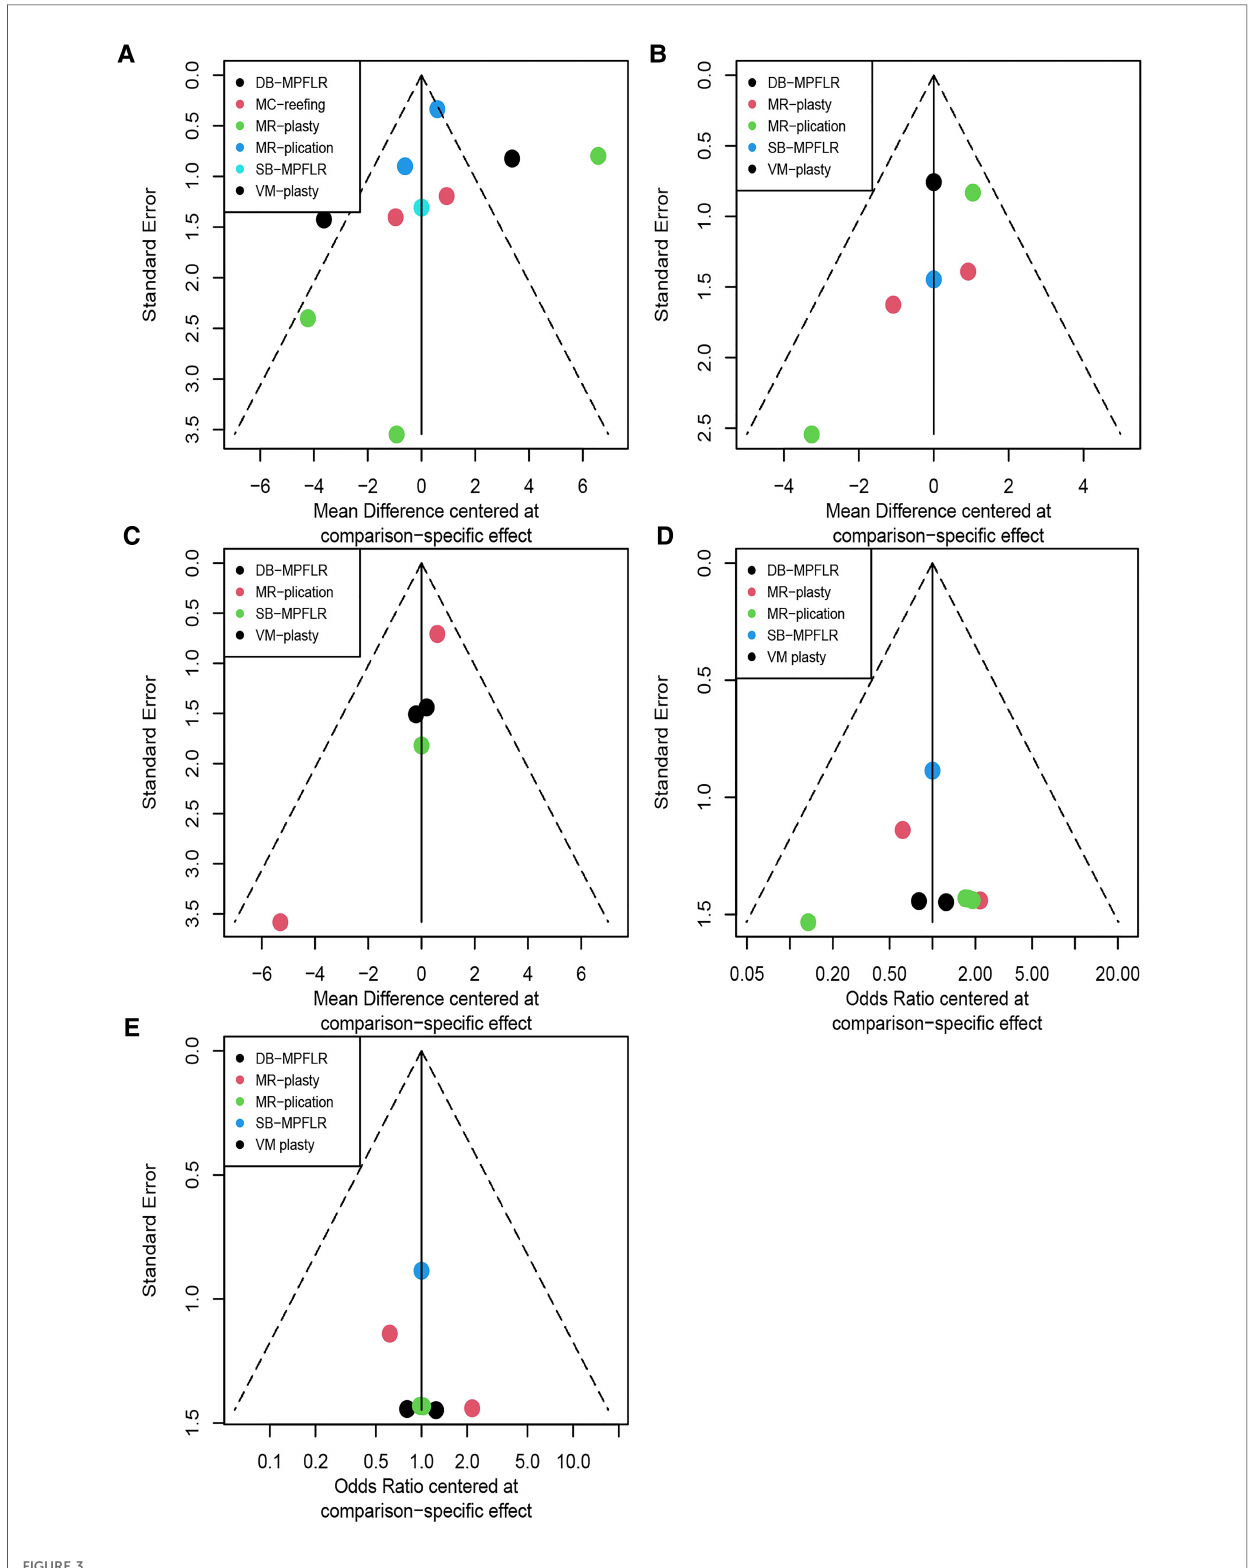
FIGURE 3 Adjusted funnel plot of different surgeries: ( A ) kujala score; ( B ) lysholm score; ( C ) IKDC score; ( D ) redislocation; ( E ) recurrent